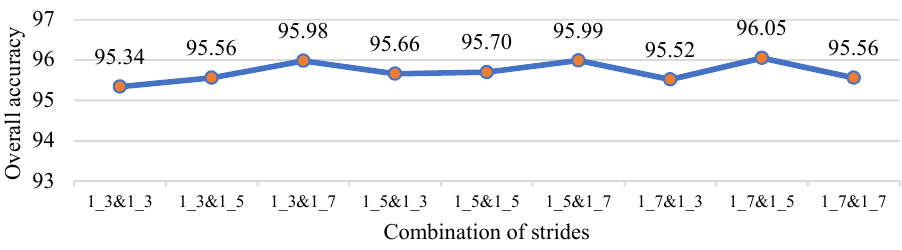
Figure 11. Accuracy of different stride combinations on the Pavia University dataset.